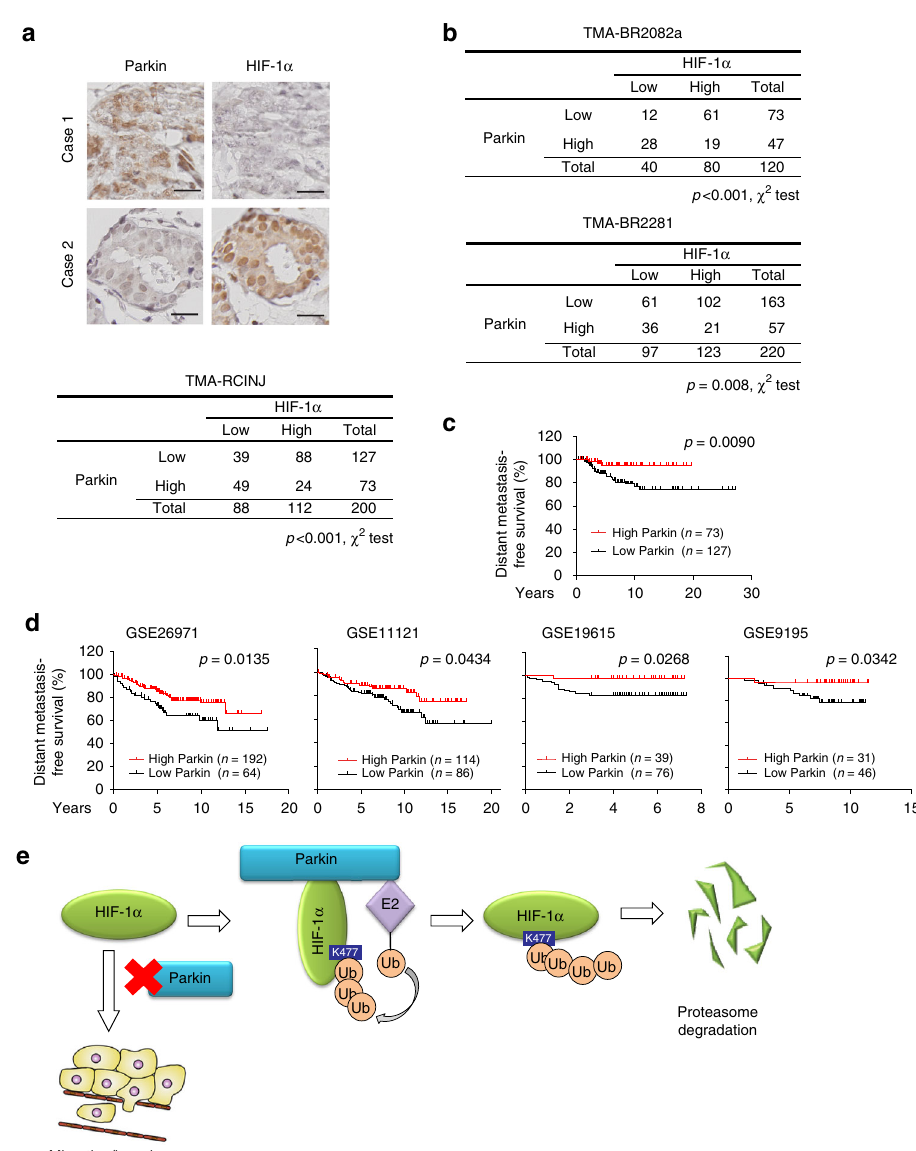
Fig. 8 Low Parkin expression is correlated with increased HIF-1 α levels and poor distant metastasis-free survival in human breast cancer. a , b Low Parkin expression was signi fi cantly correlated with increased HIF-1 α levels in human breast cancer specimens analyzed by IHC staining. Upper panel in a : representative IHC staining images in TMA-RCINJ ( n = 200, from the RCINJ). Scale bar: 20 µ m. Lower panel in a : summary of IHC staining results of human breast cancer specimens in TMA-RCINJ. b Summary of IHC staining results in two different cohorts of human breast cancer specimens in TMAs ( n = 120 in TMA-BR2082a; n = 220 in TMA-BR2281 from US Biomax). c , d Low Parkin expression was signi fi cantly associated with poor distant metastasis- free survival in human breast cancer. In c , low Parkin expression was signi fi cantly associated with poor distant metastasis-free survival in TMA-RCINJ. In d , the survival information and mRNA levels of Parkin were obtained from GEO databases. In c , d : Kaplan – Meier curves were drawn by GraphPad Prism software. Differences between the two survival curves were analyzed using the log-rank (Mantel – Cox) test. e A model depicting the suppression of cancer metastasis by Parkin-mediated HIF-1 α ubiquitination and